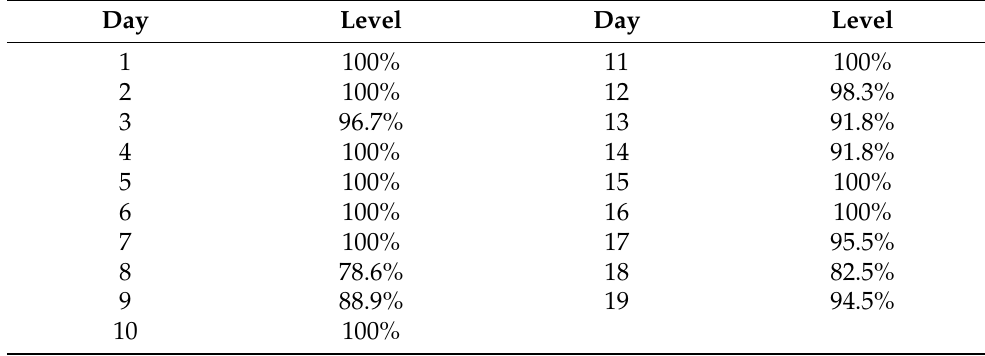
Figure 2. Divisions created in a zone of the city studied in the case study (figure ( a ) shows the north and central area, while figure ( b ) shows the central and south area). The territories are shown in different colors with the basic units delimited by white lines. Table 6. Level of service reached by the proposed solution for each of the 19 days where which information is